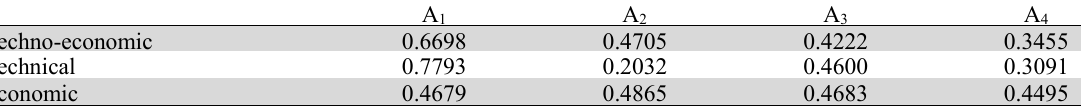
Closeness coefficient of the light